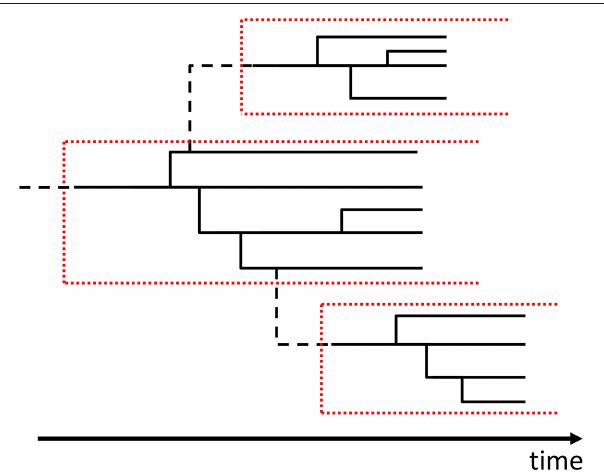
FIGURE 4 | An example of the evolutionary tree for the Yule process. The black solid lines show the branchings of species. The black broken lines show the branchings of genera. One genus is represented by the part surrounded by the red dotted lines. In this figure, though, the probability of branching for a new genus seems to depend on the number of species in the original genus and, in fact, the Poisson rate for branching of a genus is constant in the Yule